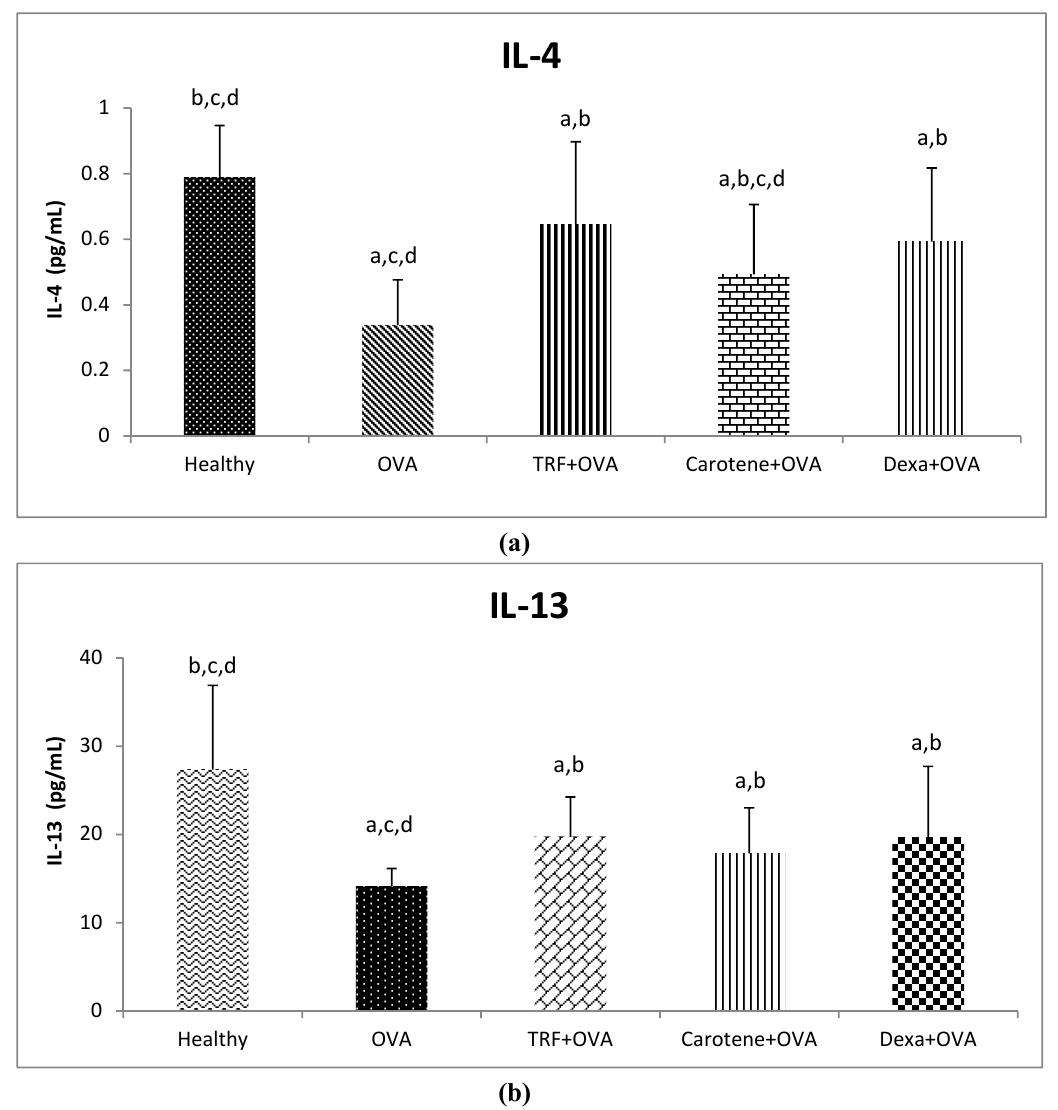
Figure 6. Plasma concentrations of ( a ) IL-4 and ( b ) IL-13 after treatment with palm oil TRF, carotenes, and dexamethasone (Dexa). Data are presented as the means ± SD, n = 10 rats per group. a P < 0.05 versus the control group, b P < 0.05 versus the OVA-challenged group, c P < 0.05 versus OVA + TRF, d P < 0.05 versus OVA +